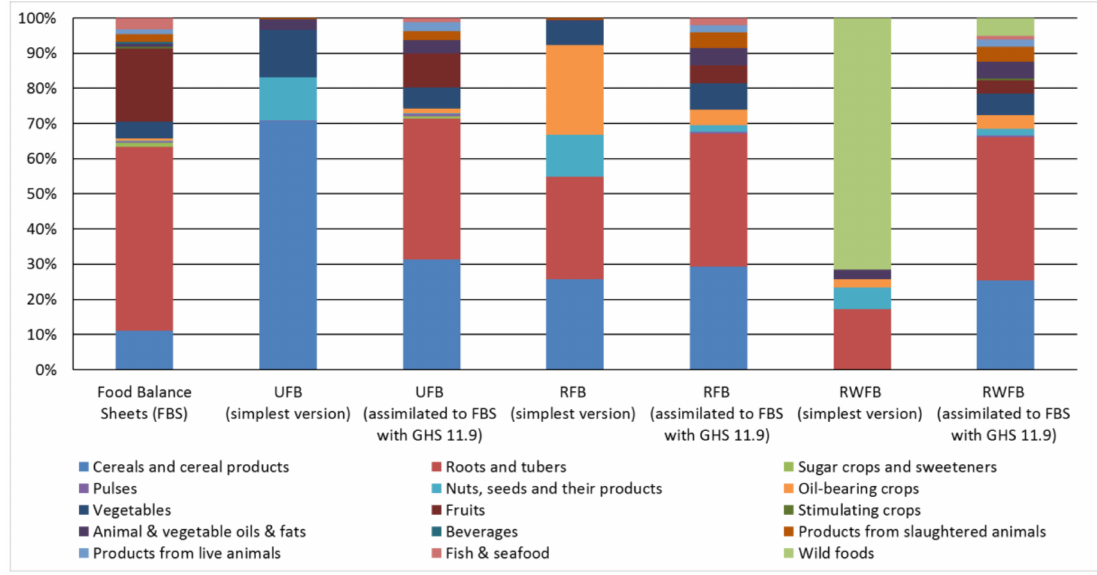
Figure 3. Food categories constituting the current food supply (left column), the simplest version of the UFB, RFB and RWFB and their more culturally acceptable forms that were aligned to current supply of food categories. The wild foods consisted of mango, dandelion, moringa, amaranth leaves, Jew’s mallow leaves, Giant African snails and waterleaves. FBS: Food Balance